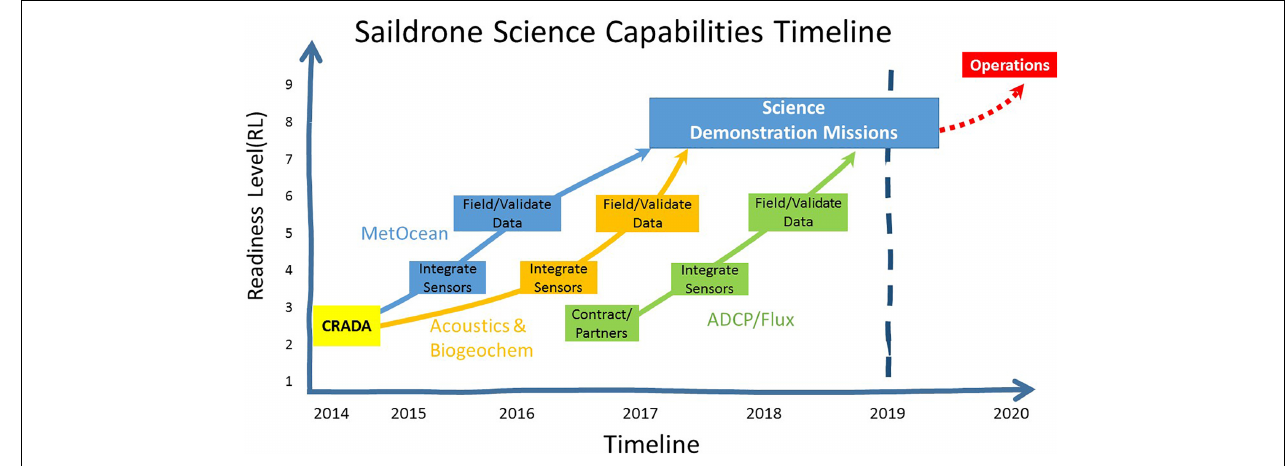
FIGURE 4 | Timeline of Readiness Level for Saildrone USV sensor